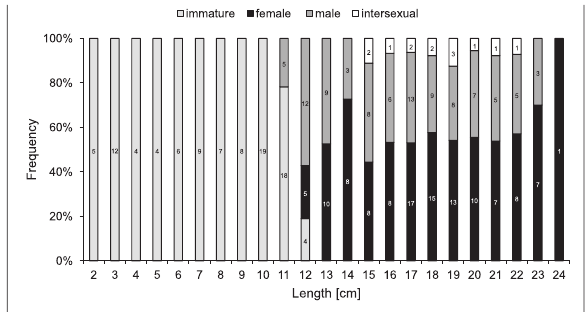
Fig. 2. Proportion of immature, female, male,